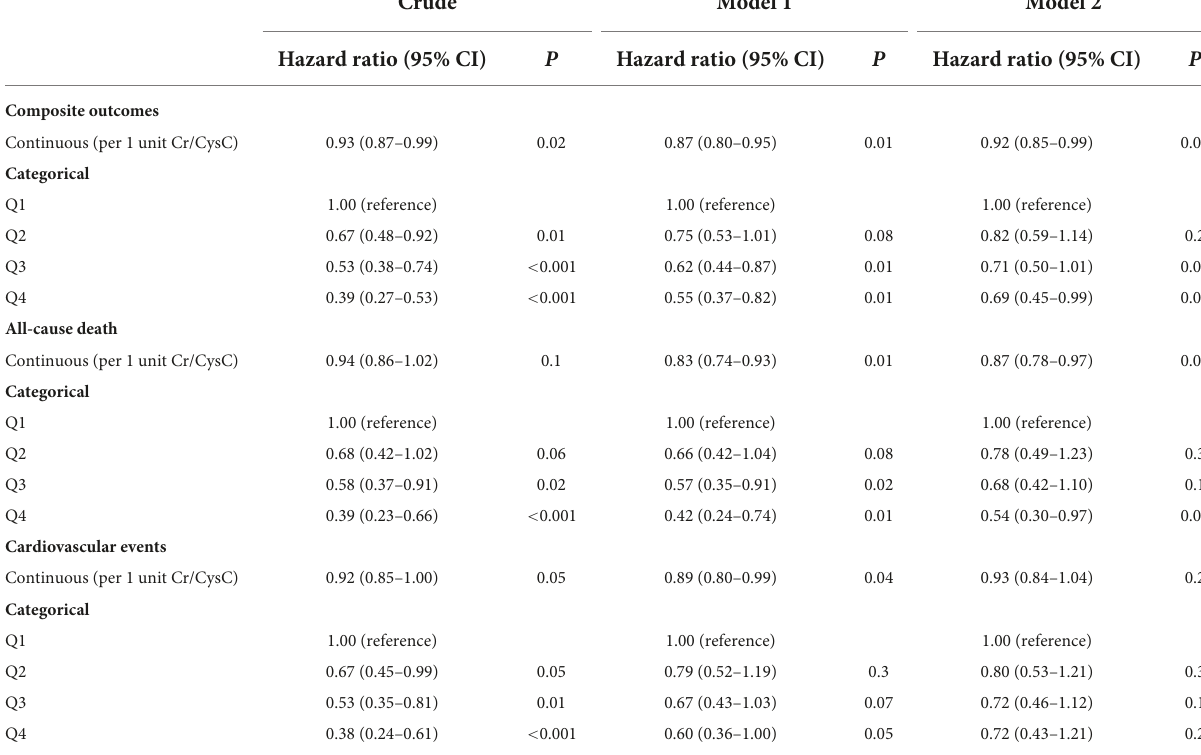
TABLE 3 Hazard ratio for death and cardiovascular events based on the Cr/CysC ratio in 1,966 adults with chronic kidney disease.